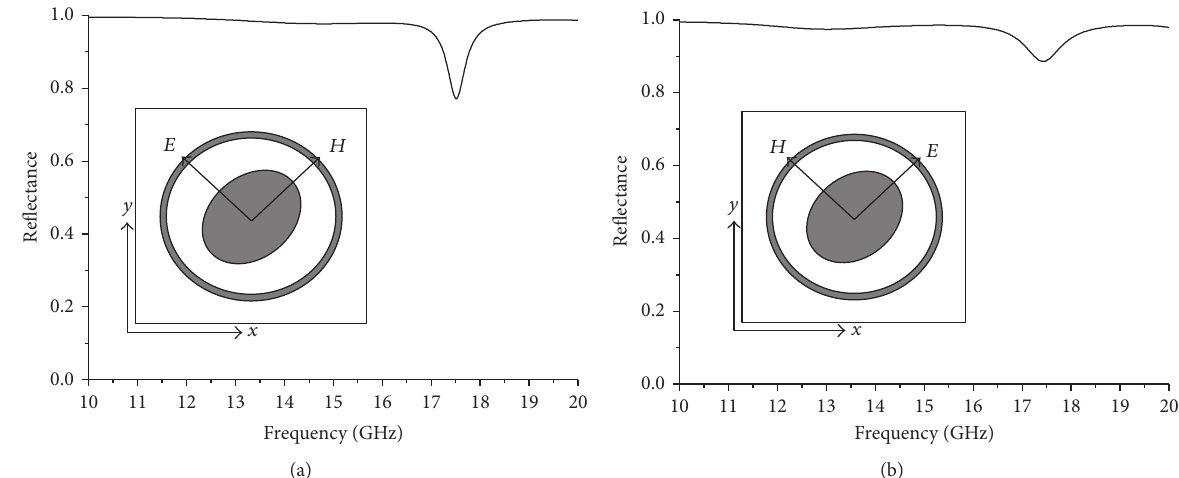
Figure 2: The amplitudes of the reflectance under the illumination of (a) major axis and (b) minor axis polarized